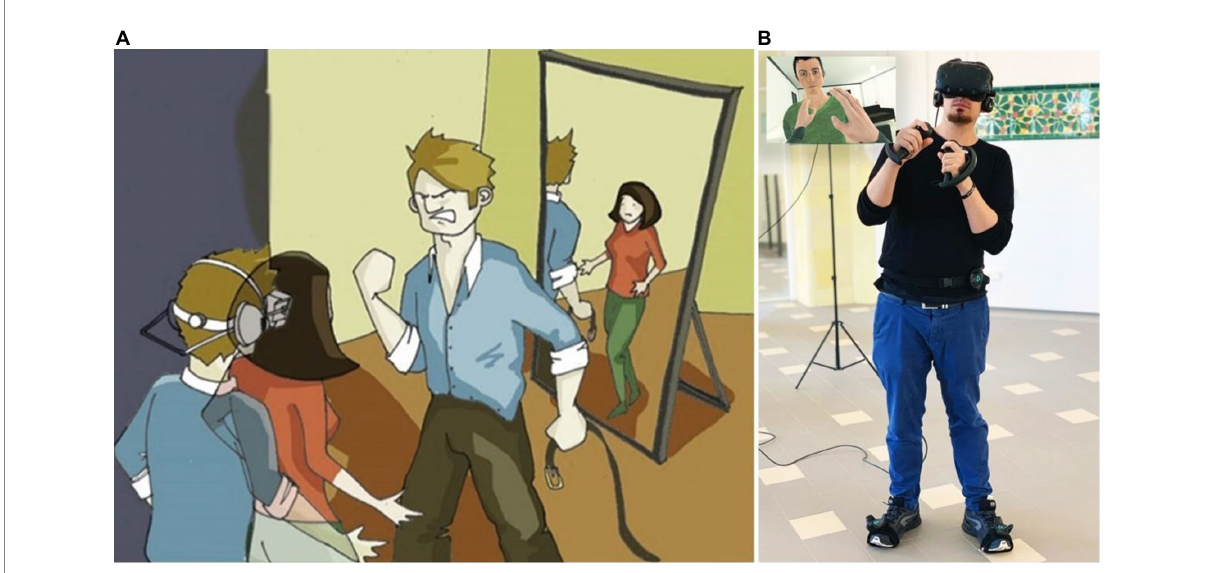
FIGURE 3 In the body and the perspective of the victim. (A) Scheme of the situation in which a male is wearing a head-mounted display to embody a female who is a victim of intimate partner violence. Drawing made by Elias Giannopoulos. (B) Image of a participant using a head-mounted display and immersed in the situation depicted in (A) . In an inset, what the participant is viewing from his perspective, including his own